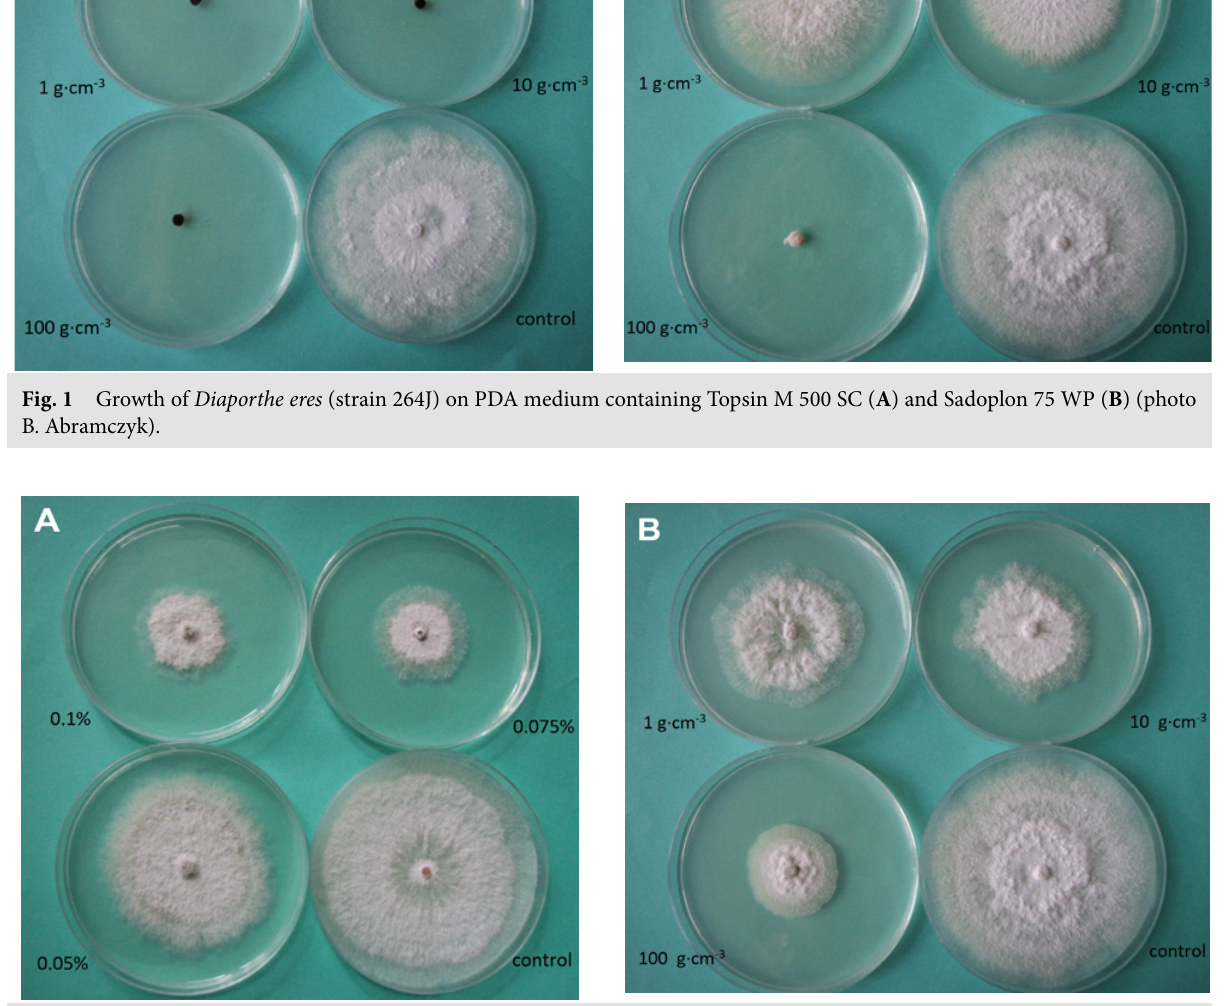
Fig. 2 Growth of Diaporthe eres (strain 264J) on PDA medium containing Discus 500 WG ( A ) and Kaptan 50 WP ( B ) (photo B. Abramczyk).